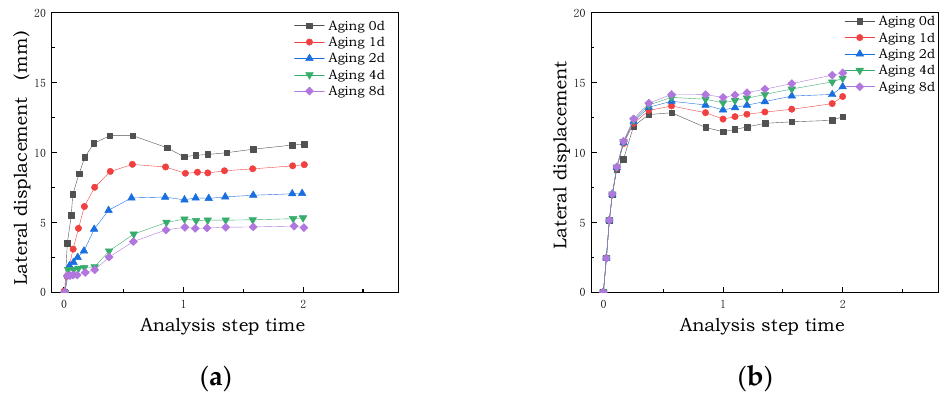
Figure 7. The lateral displacement of the joint varies with the time of the analysis step: ( a ) considering the rubber aging, the lateral displacement of the node varies with the analysis step time; ( b ) considering the aging of the cord, the lateral displacement of the node varies with the analysis step time.